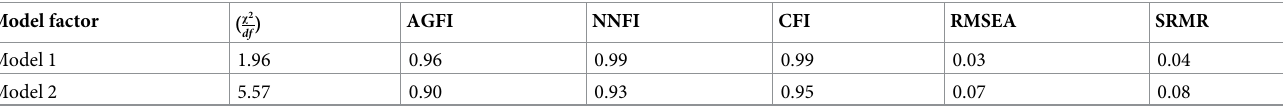
Table 4. The goodness of fit indices of the factor model. Model